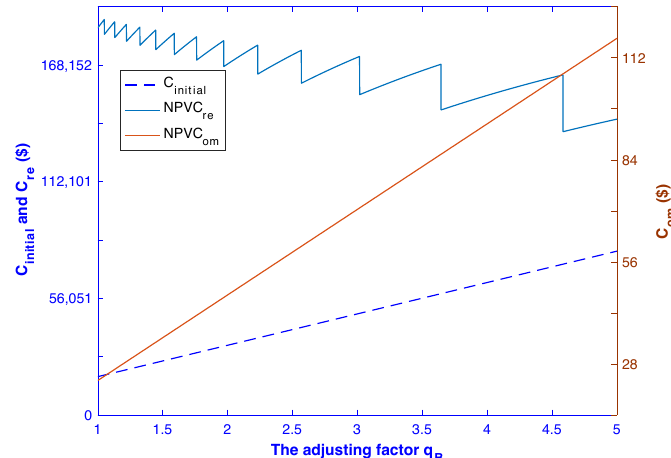
Figure 10. The costs for different values of q B .